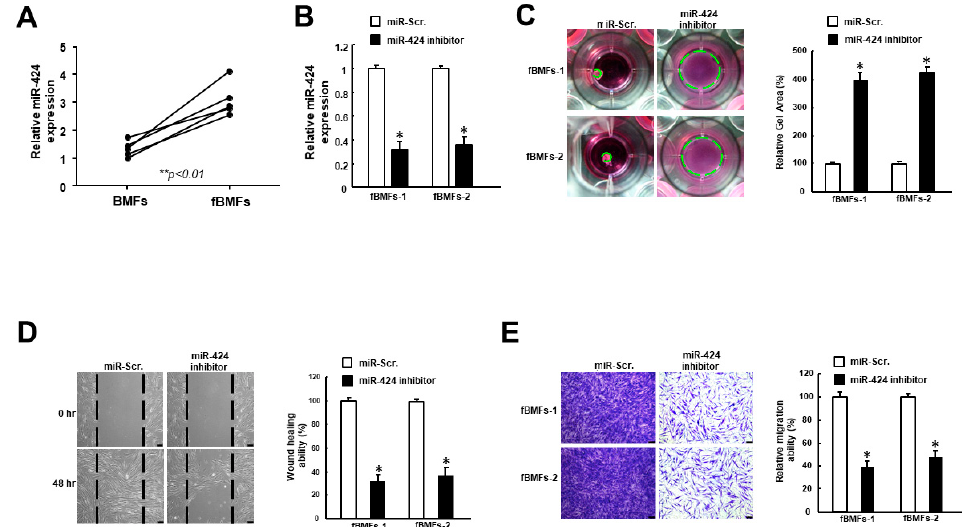
Figure 2. The downregulation of miR-424 in fibrotic buccal mucosal fibroblasts (fBMFs) diminishes several myofibroblast phenotypes. ( A ) The expression level of miR-424 was elevated in fBMFs compared to BMFs. ( B ) The expression of miR-424 was markedly reduced using miR-424 inhibitor. A number of myofibroblast characteristics, including ( C ) collagen gel contraction, ( D ) wound healing, and ( E ) transwell migration capacities, were all suppressed in fBMFs receiving miR-424 inhibitor. * p < 0.05 compared to miR-Scr. group.